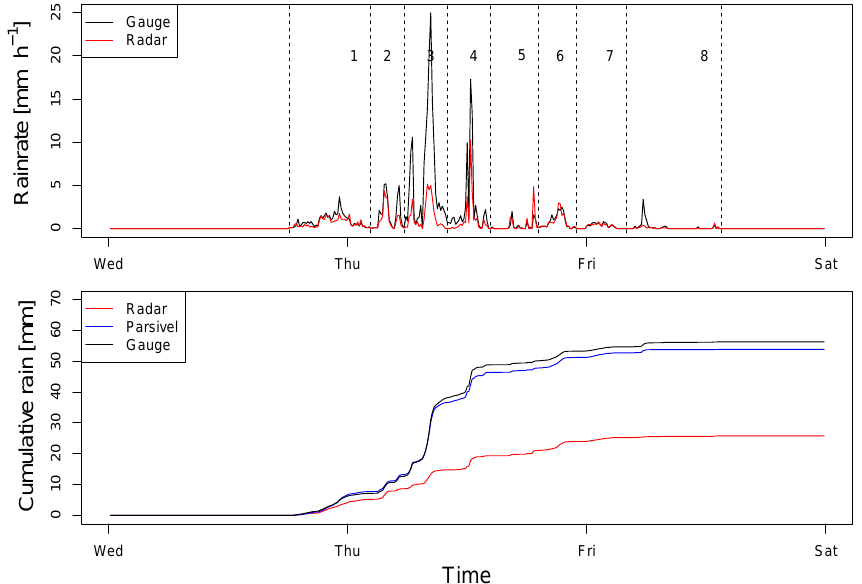
Figure 3. Top panel: time series of the rain event, with the rain rate from the rain gauge in black, and in red, the rain rate derived from the radar reflectivity using the Marshall–Palmer Z – R relation (M–P). The vertical dashed lines divide the event into eight different episodes. Bottom panel: cumulative sum of rainfall from the three instruments before any correction of the radar and using the M–P relation.